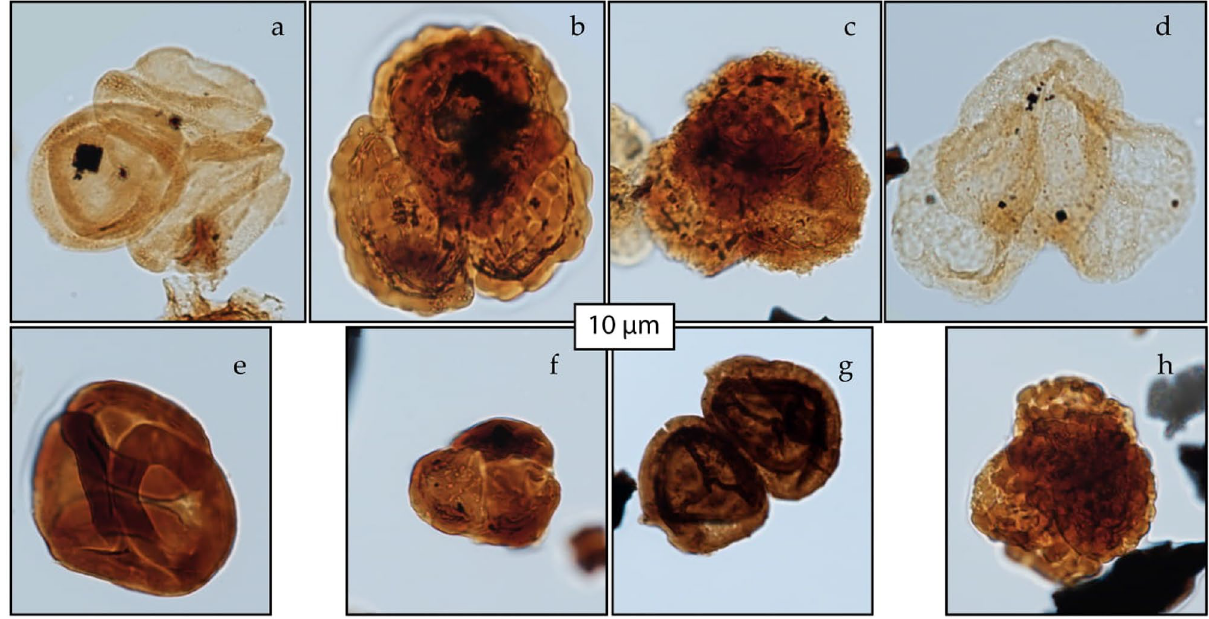
Figure 3. Selected spores and pollen from the OAE 2 of Cassis (southeast France). The sample number is followed by England Finder coordinates. (a), (f)= Classopollis classoides (tetrad) , sample CAF 10, V51/4; CB 8, O34/1; (b), (h)= Leptolepitides sp. (tetrad) , sample CAG 35, O30; XI-M-19, K36/1; (c)= Kraeuselisporites sp. (tetrad) sample CAF 5, Y35; (d)= Alisporites sp. (expanded central body and folded left saccus) , sample